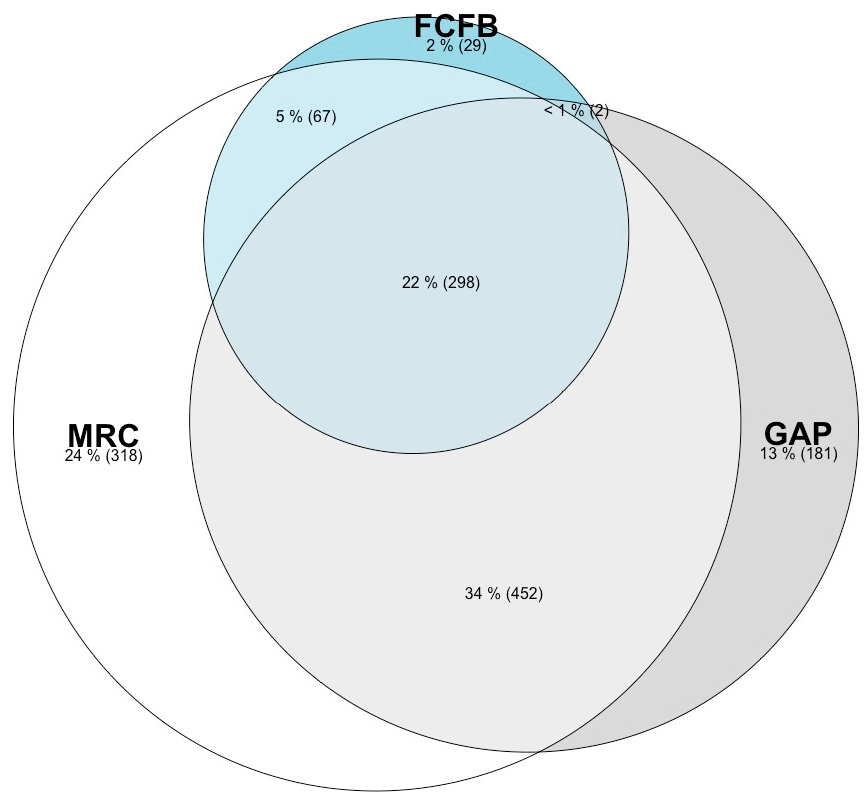
Figure 2. Euler diagram of the fish species richness (ellipse size) found within each species list and the shared overlap of species identities. The Mekong River Commission’s (MRC; white) list had a total of 1135 species. The GAPeDNA (GAP; gray) list based on Tedesco et al. [11] had 933 species, and the Field Guide to Fishes of Cambodia Freshwater Bodies [33] list (FCFB; blue) had 396. The ZIV database (not shown) is comprised of 103 known migratory fish species, 102 of which are found in the MRC database with the remaining one found in the GAP database (100% found within GAP). Percent labels reflect the number identified within the subset divided by the total fish species listed (UNION; n = 1345